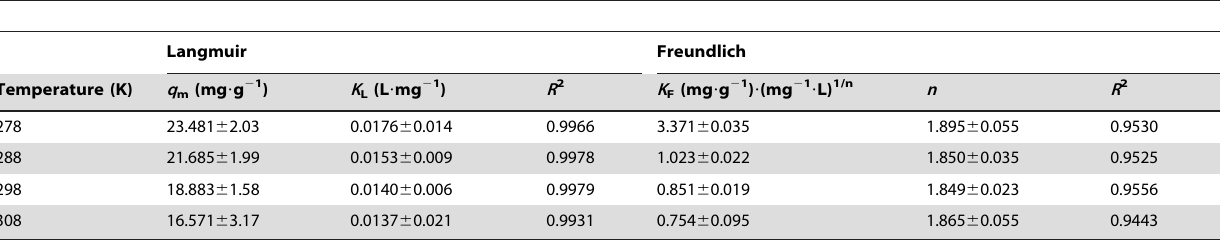
Table 2. Isotherm parameters for the biosorption of Cd 2 + in solution at different temperatures.